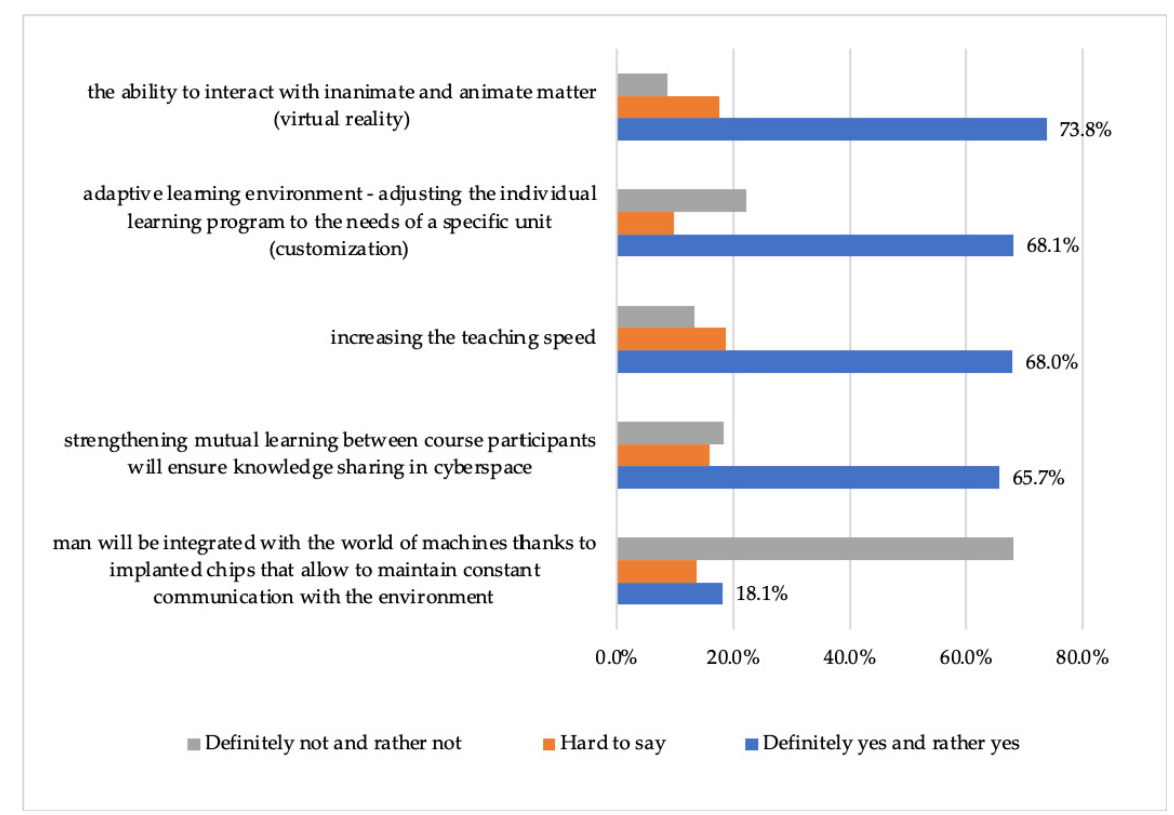
Figure 5. Manifestations of Artificial Intelligence (AI) in the education of the future.